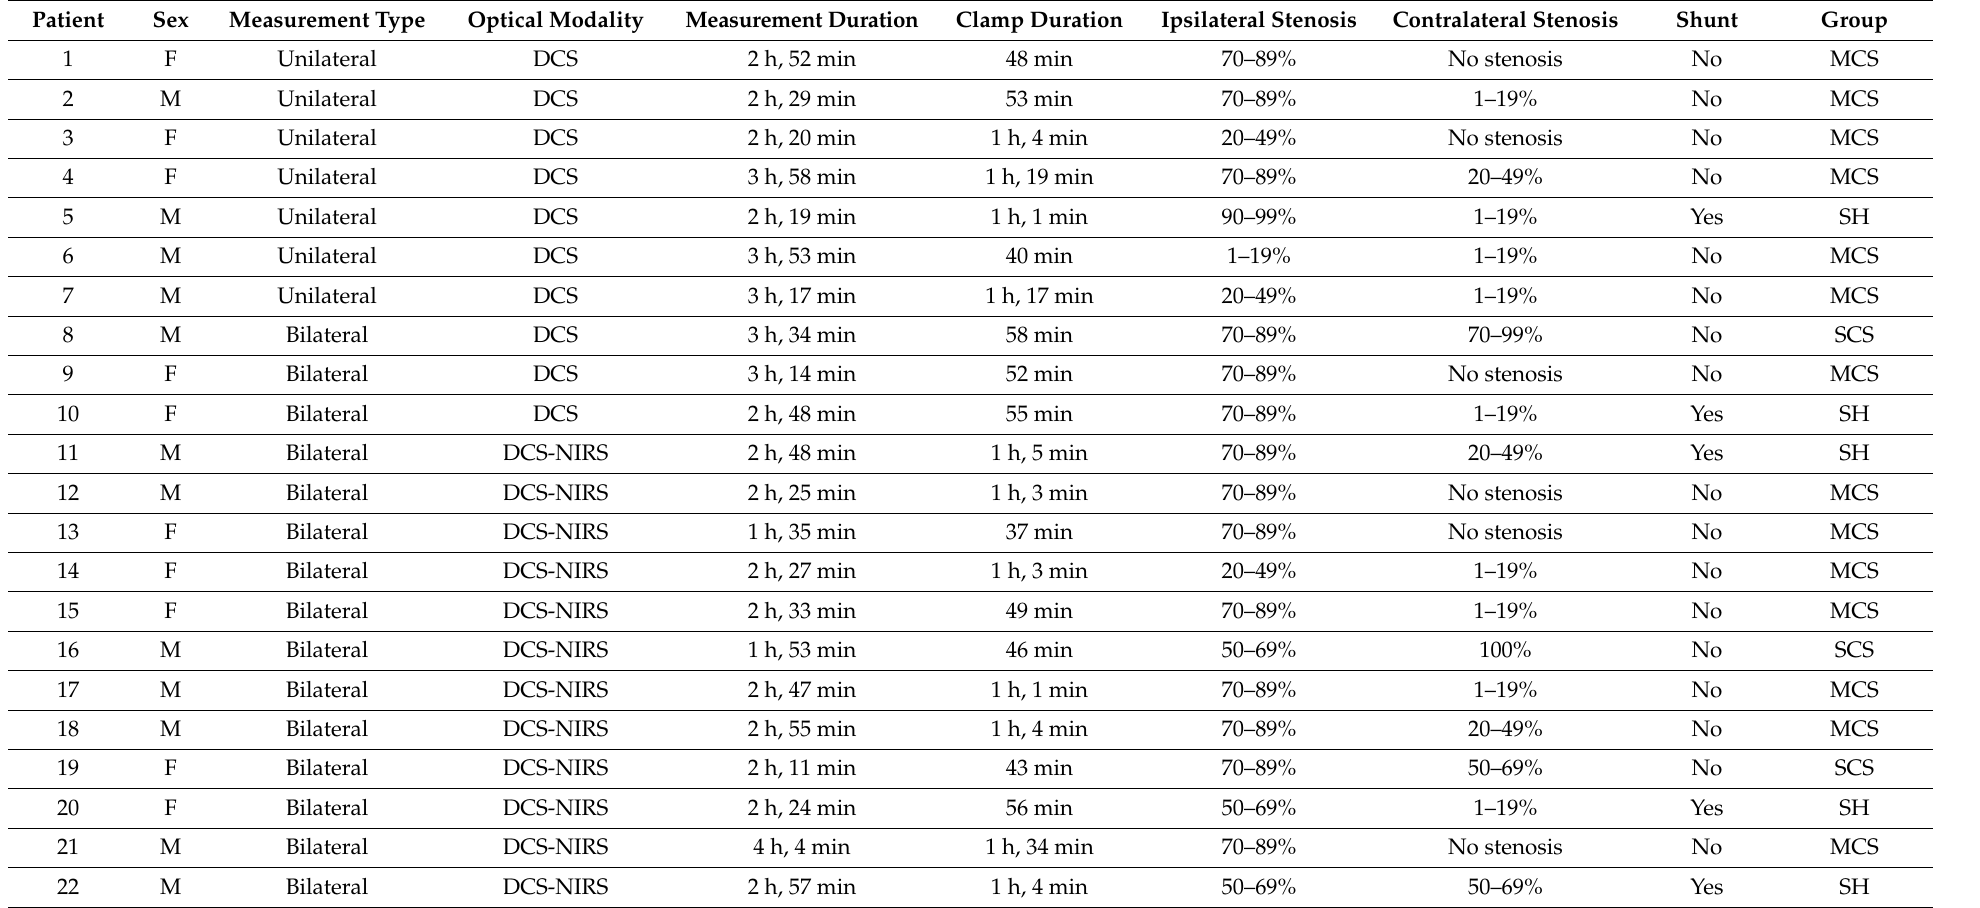
Table 1. Measurement and patients’ clinical